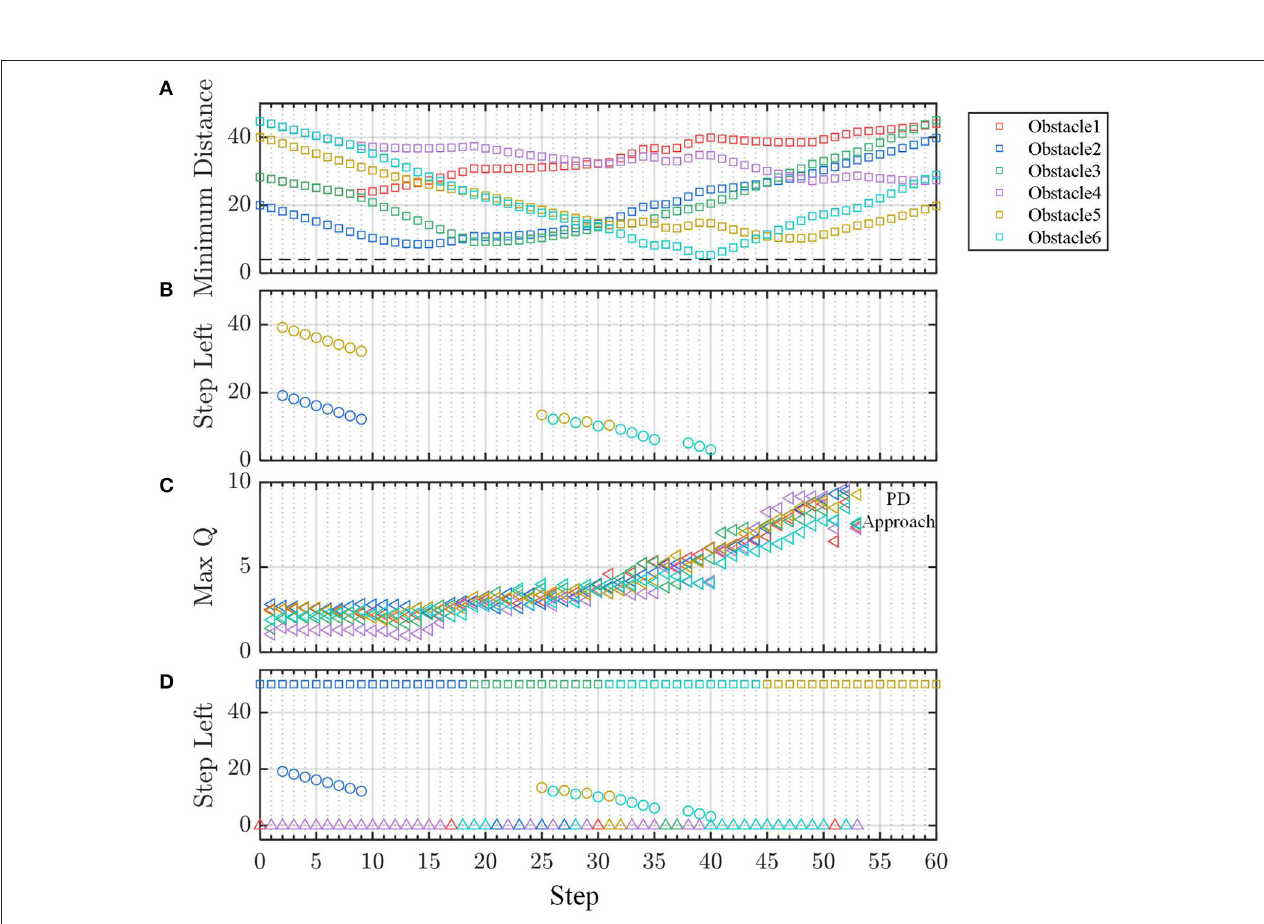
FIGURE 12 | The (A) distance, (B) prediction of left steps, (C) Q value of the fused policy for obstacles. (D) Comparison of three kinds of threat prediction.